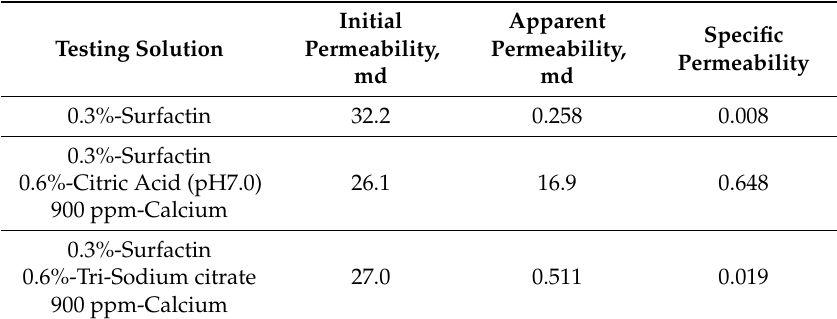
Table 2. Results of the surfactin injectivity tests.